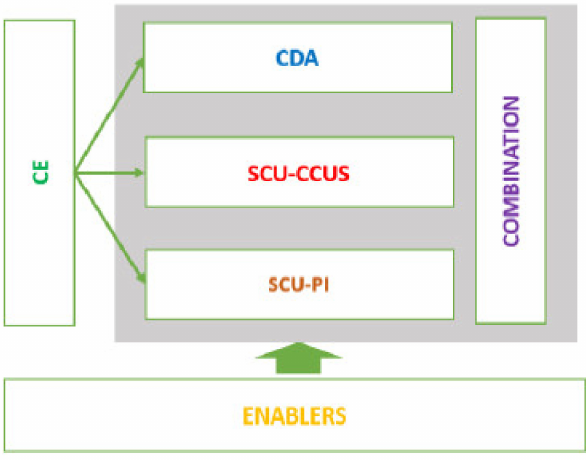
Figure 17. Areas of intervention and their interactions [1].